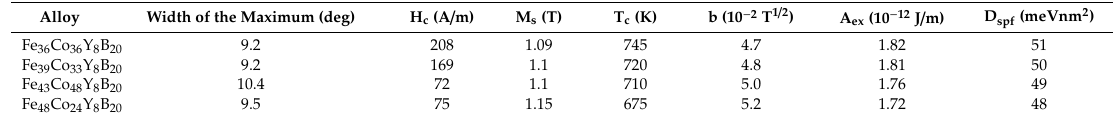
Table 2. Magnetic properties of the tested alloys.